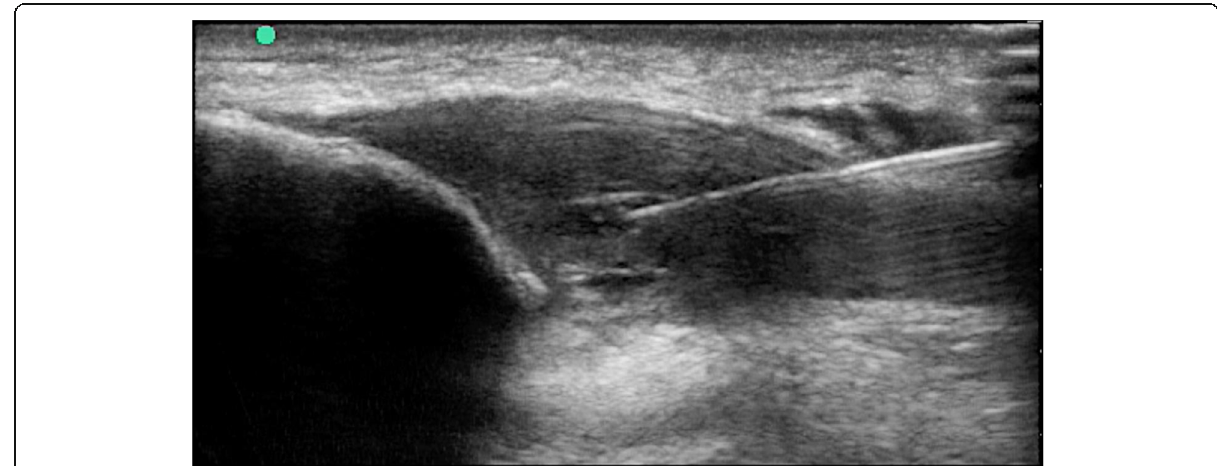
Fig. 1 Ultrasound guided cell injection into the hypoechoic area of the proximal patellar tendon